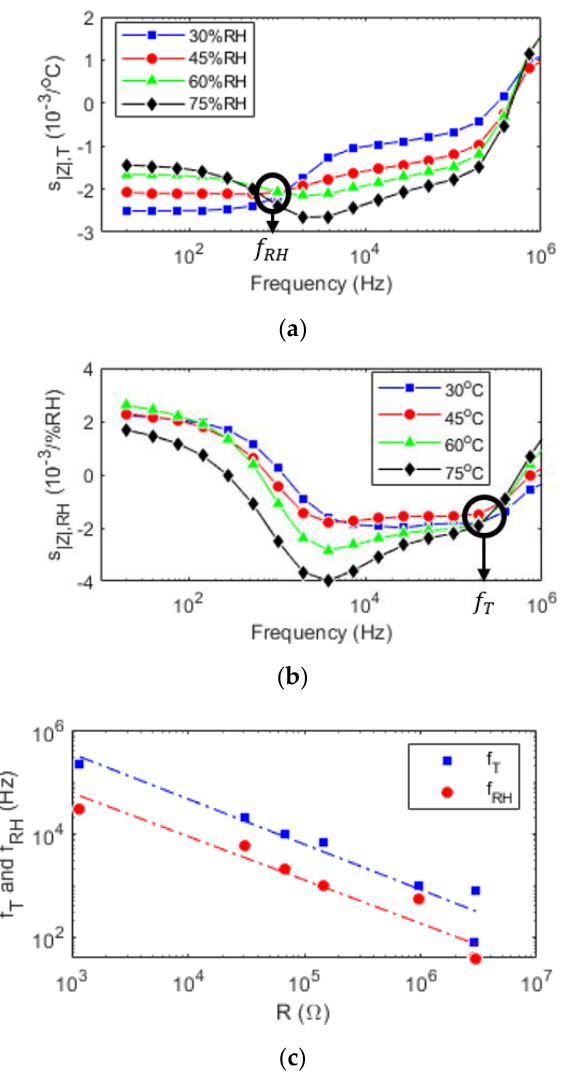
Figure 4. Source separation. ( a ) Relative impedance magnitude sensitivity to temperature of different moistures and frequencies. ( b ) Relative impedance magnitude sensitivity to moisture of different temperatures and frequencies. ( c ) Non-response temperature or moisture frequencies of different fabricated sensors represented via their resistance.